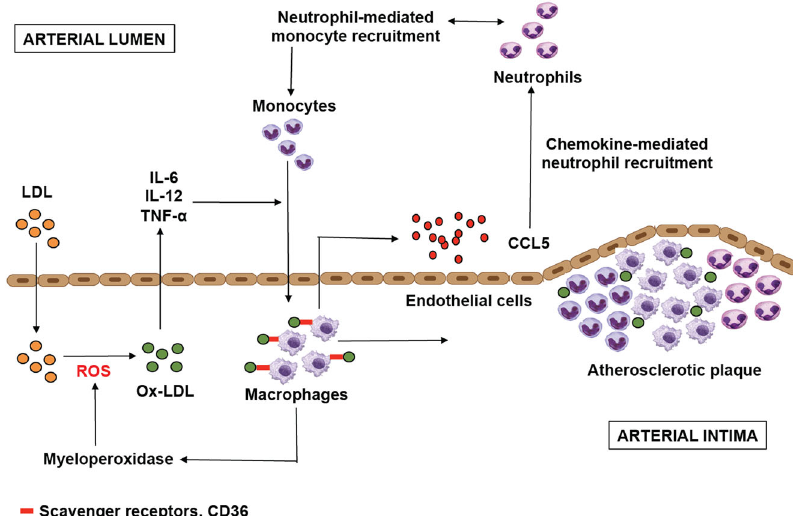
Fig. 1 Schematic representation of in fl ammatory mechanisms involved in pathogenesis of atherosclerosis and plaque formation. LDL is retained in arterial intima via ionic interactions with endothelial cells, leading to the enzymatic oxidative modi fi cation of LDL into OxLDL. This is followed by secretion of pro-in fl ammatory cytokines that leads to the differentiation of monocytes into macrophages. Macrophages secrete more chemokines and mediate recruitment of neutrophils via scavenger receptors and further attract monocytes. Macrophages retained in arterial intima get converted into foam cells leading to the formation of atherosclerotic